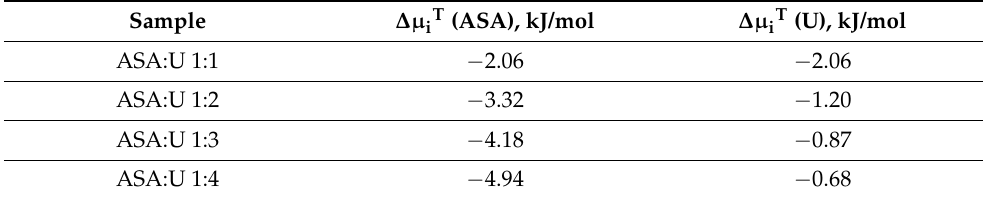
Table 4. Chemical potentials of the ammonium sulfamate–urea